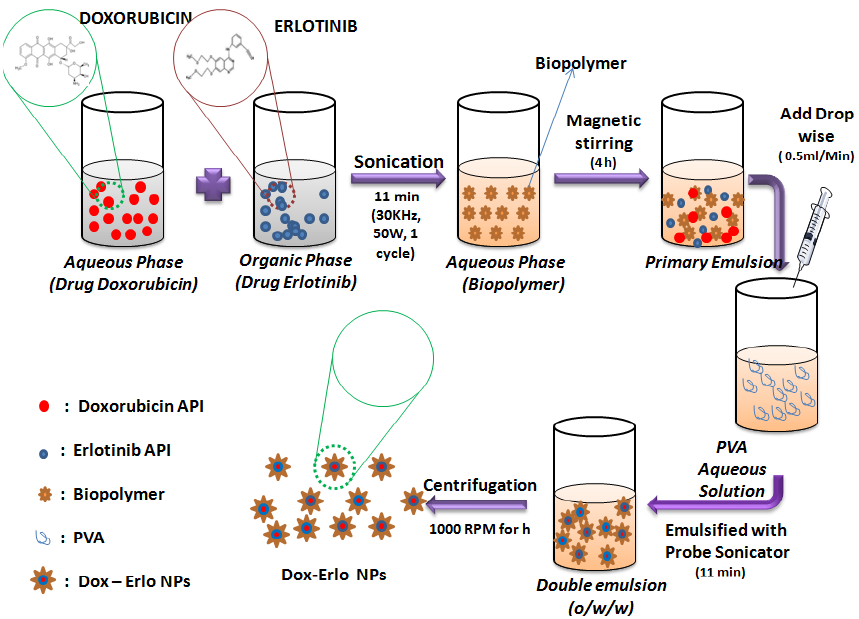
Figure 12. Schematic representation of the preparation of Dox–Erlo NPs by double-emulsion evaporation method.